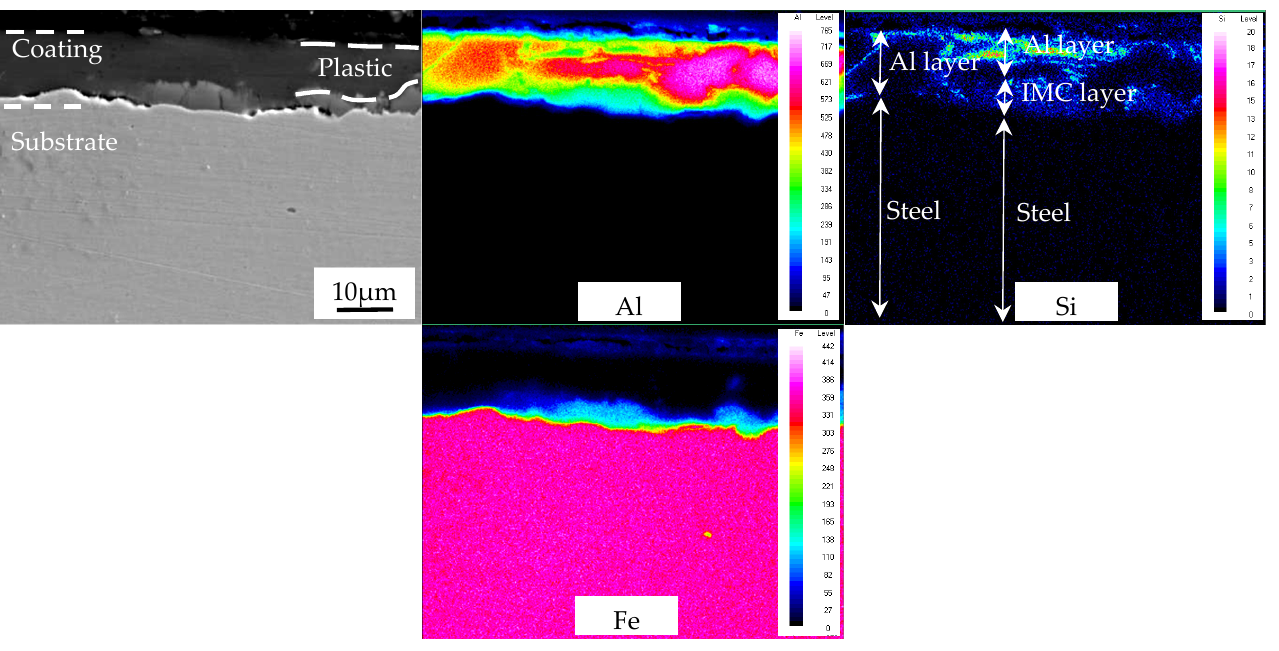
Figure 5. EDS map scan of interface between the AS60/60 coating and the steel substrate at 0% re- duction ratio.